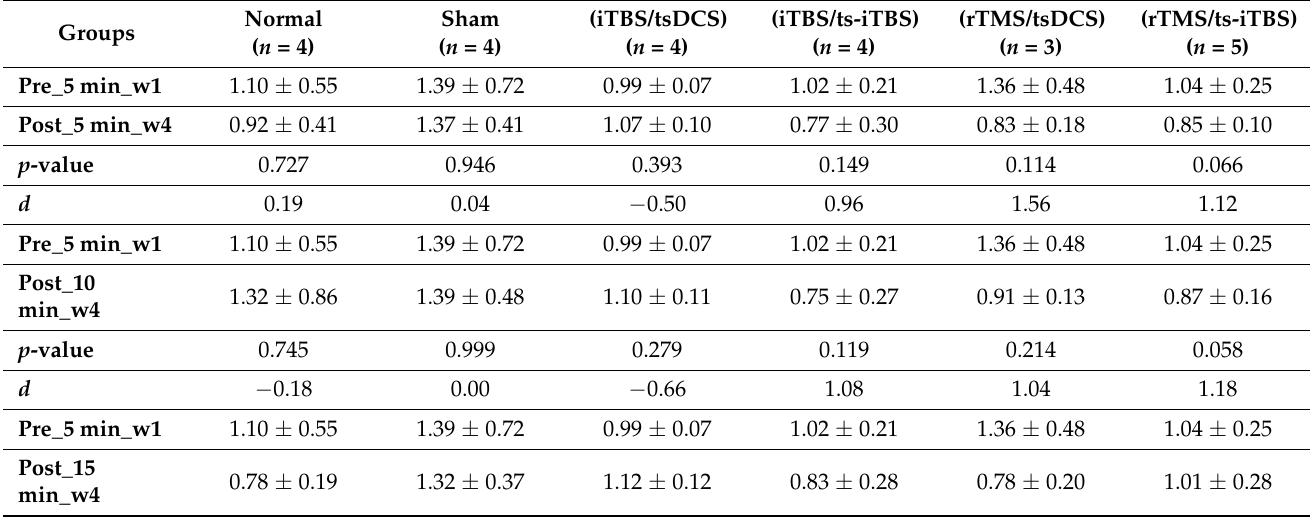
Table 1. MEP of both sides in week 1 vs. week 4 for different time points ( n =